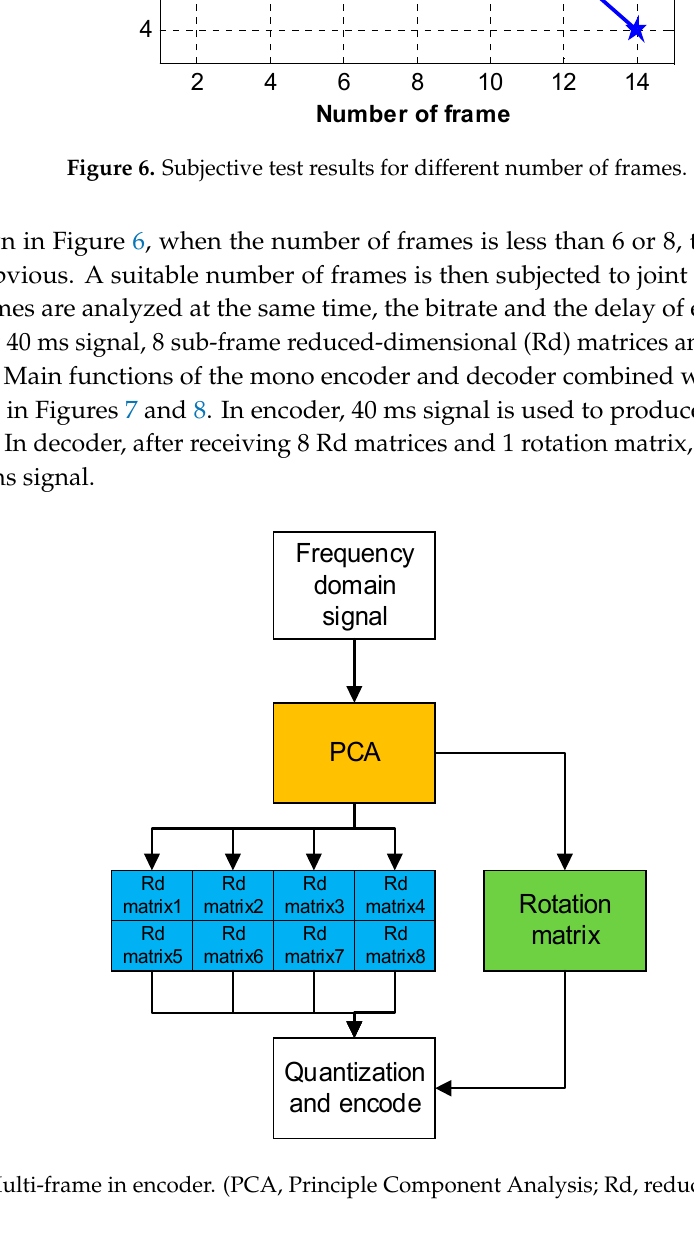
Figure 7. Multi-frame in encoder. (PCA, Principle Component Analysis; Rd, reduced-dimensional).